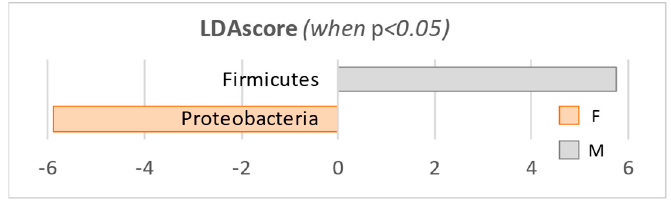
Figure 6. Results obtained by the LefSe analysis, at phylum level.